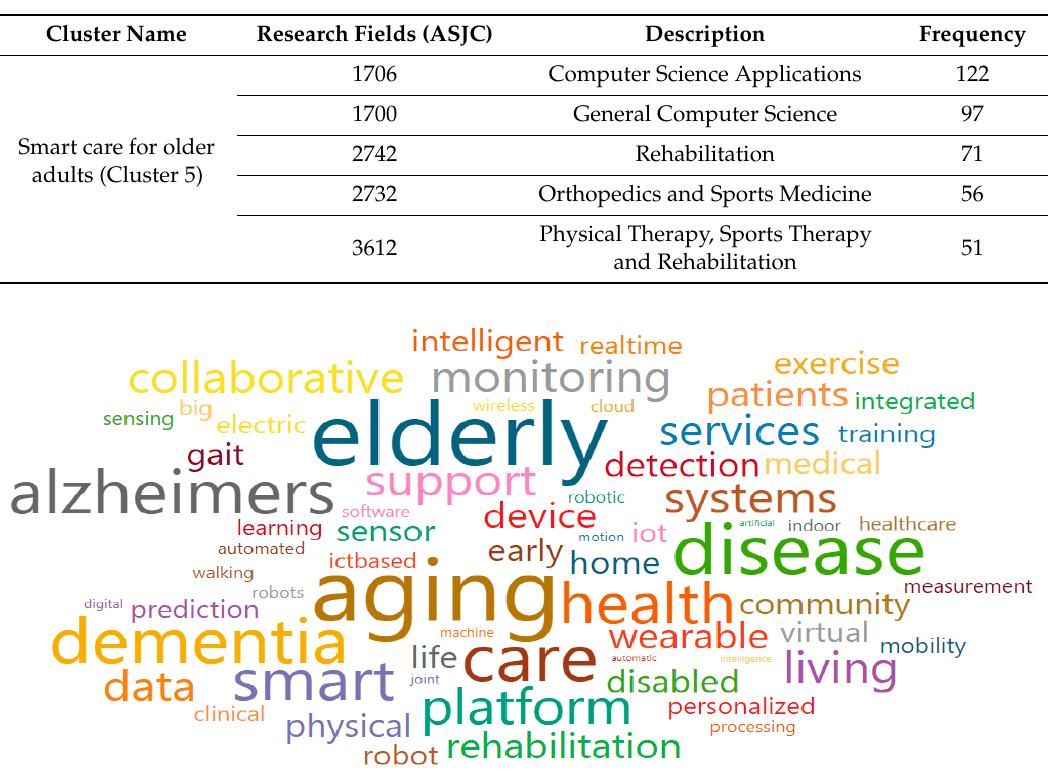
Figure 10. Words cloud in Smart care for older adults (Cluster